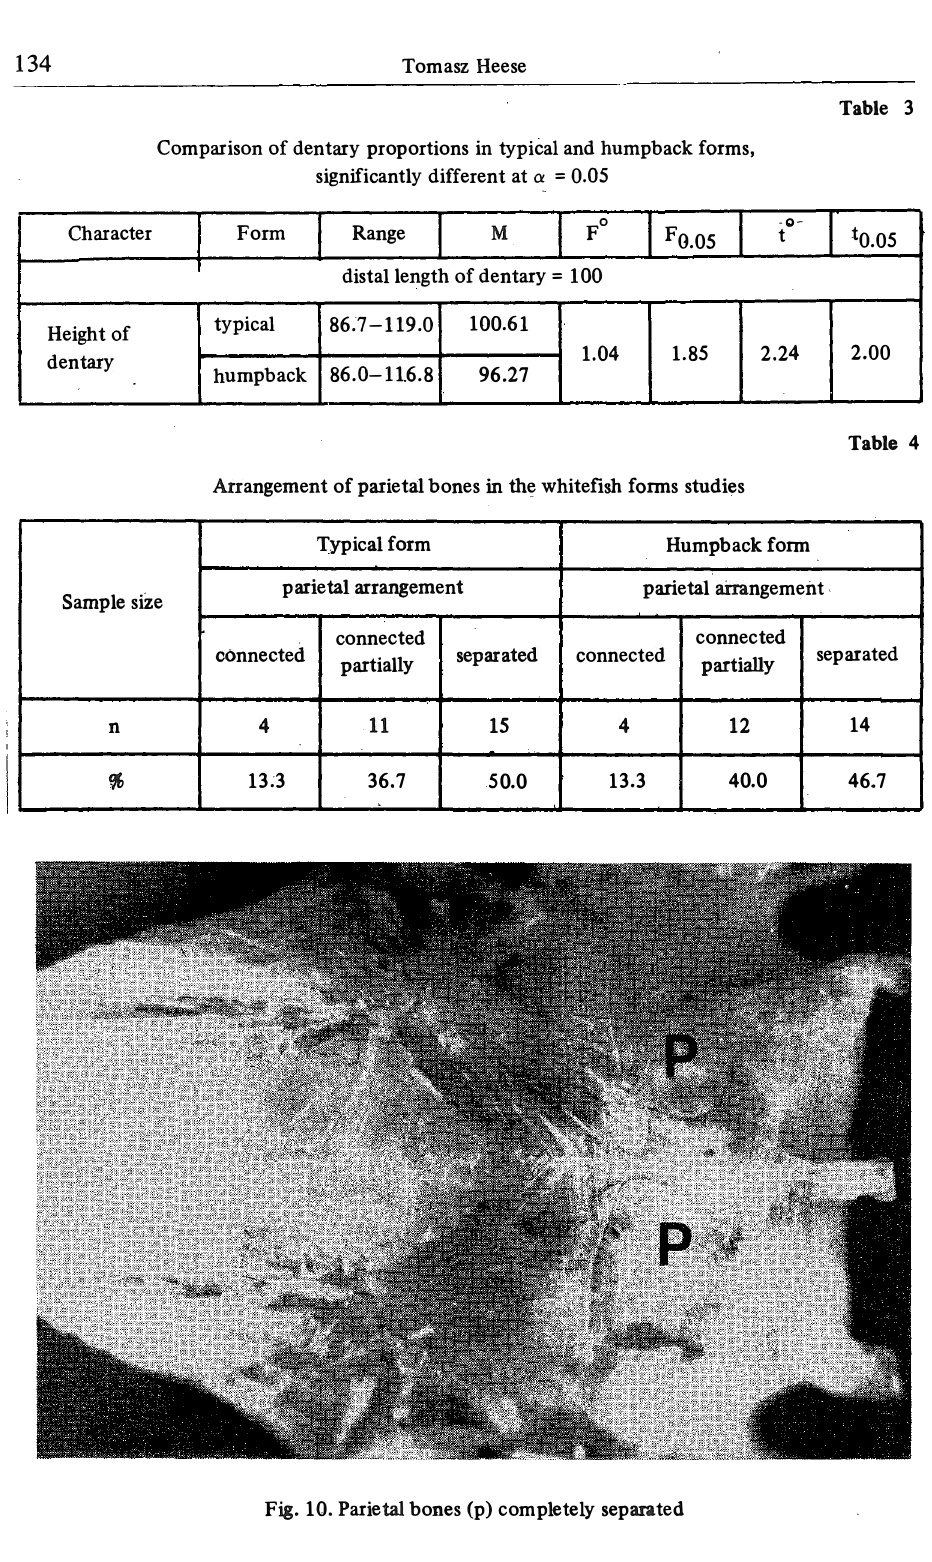
Fig. 10. Parietal bones (p) completely